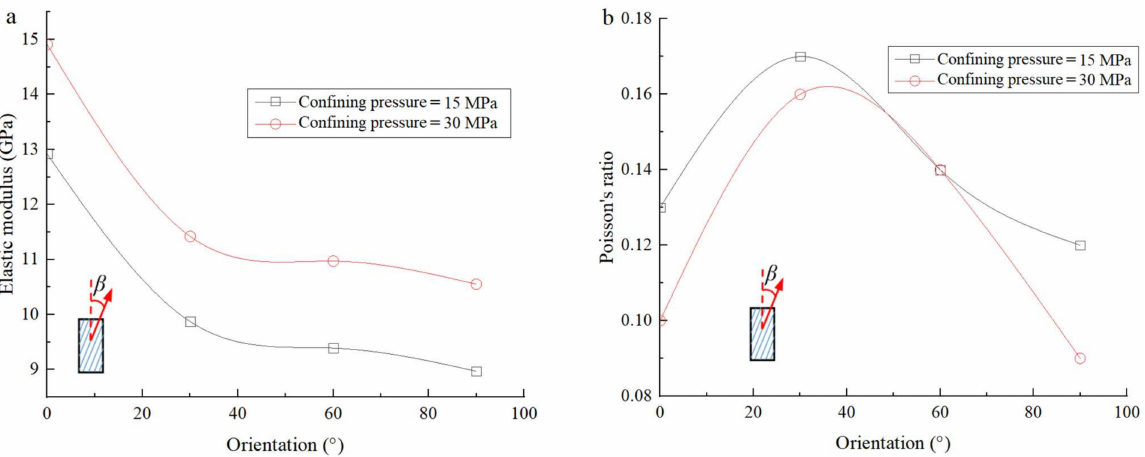
Figure 5. Changes in elastic modulus ( a ) and Poisson’s ratio ( b ) of the dry shale samples with axial direction—lamina angles ( β